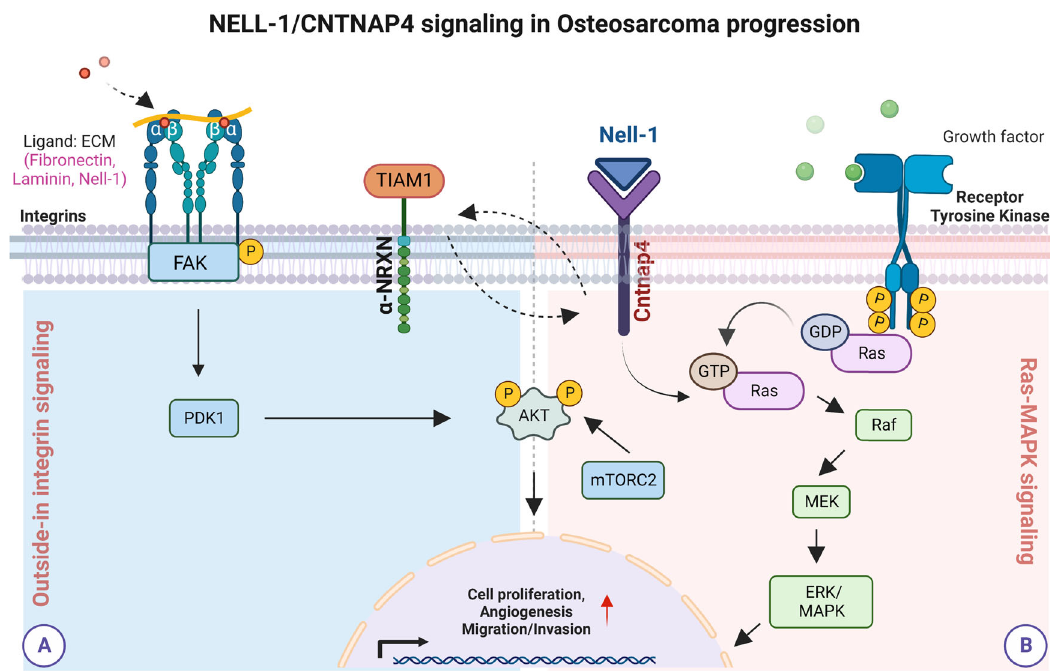
Fig. 7 Model proposing mechanism driving sarcoma progression through Nell-1/Cntnap4 signaling. As a secreted molecule, NELL-1 initiates cellular signaling through binding to its receptor, Cntnap4, on the cell surface. The Ras-MAPK/ERK and Outside-in integrin signaling pathways play critical roles initiating downstream targets during sarcoma disease progression. Cartoon created with